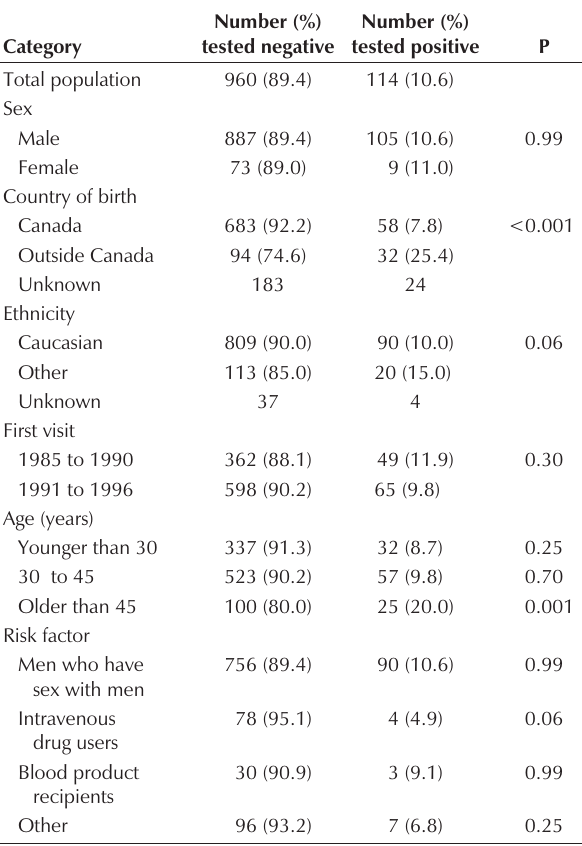
Seroprevalence of cytomegalovirus in a regional human Seroprevalence of Toxoplasma gondii in a regional human immunodeficiency virus seropositive